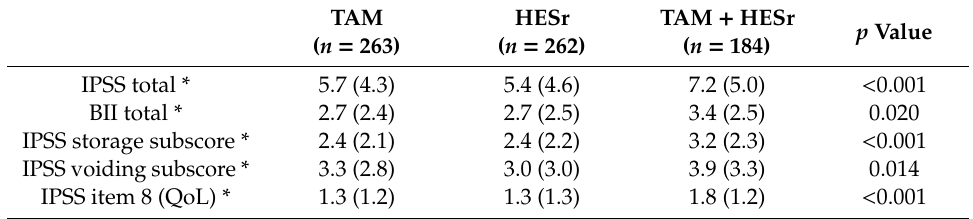
Table 2. Improvement from baseline to 6-month follow-up in symptoms and quality of life scores for the three study groups, all patients (ANOVA, ITT analysis).